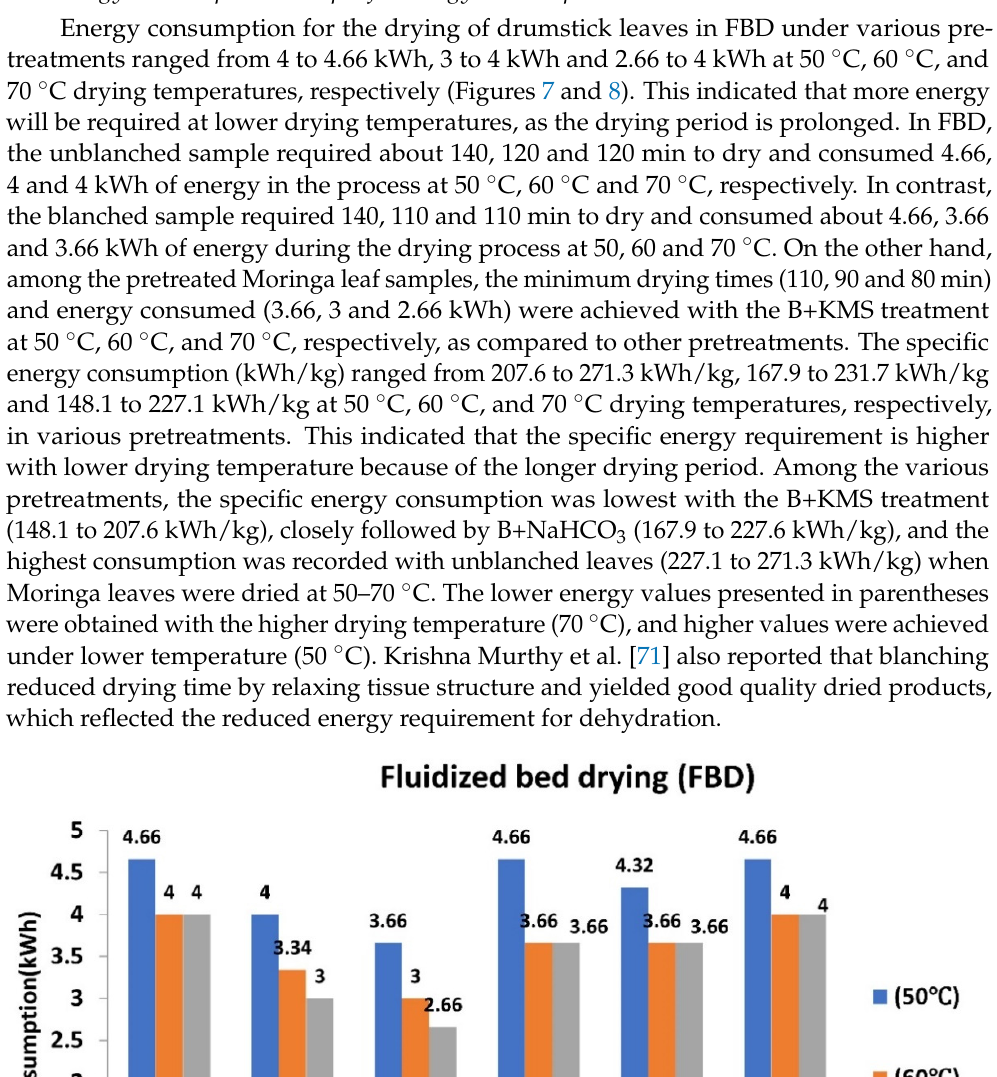
Figure 8. Specific energy consumption under various pretreatments and drying temperatures in fluidized bed dryer.